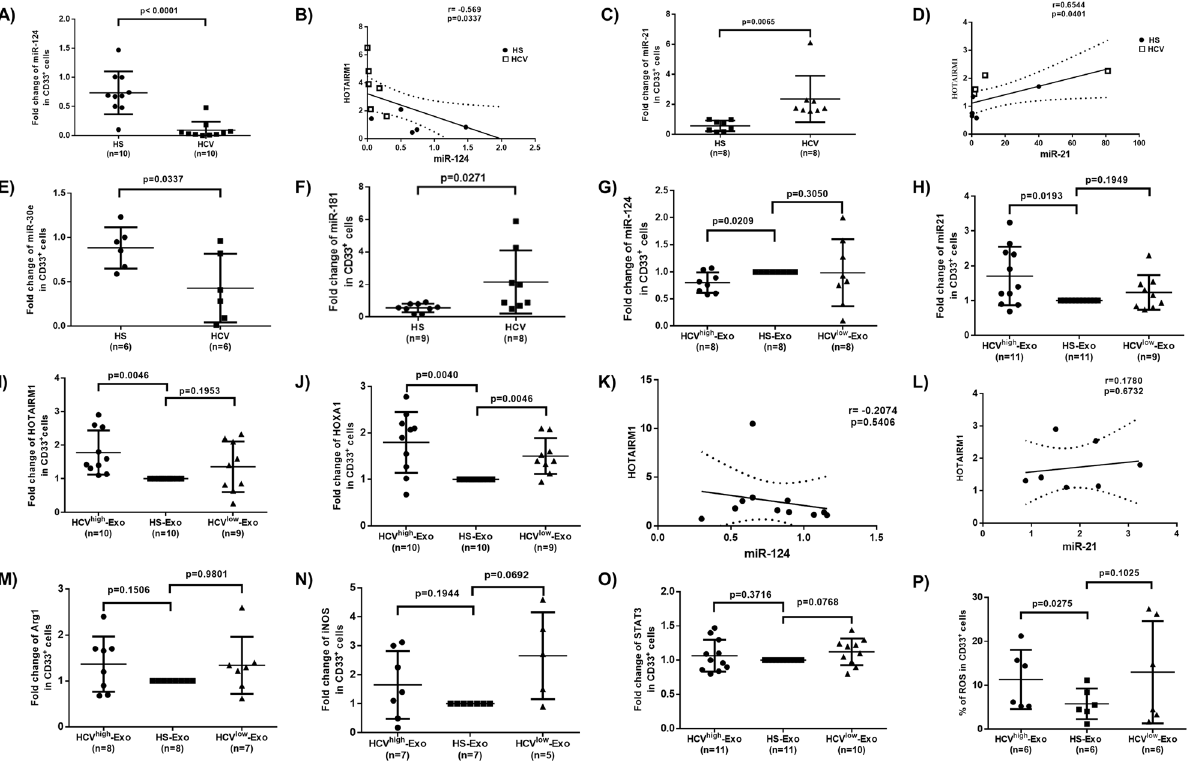
Figure 3. Analysis of miRNA, lncRNA, and mRNA expression levels in MDSCs during HCV infection in vivo and by HCV-Exo treatment in vitro. ( A–F ) Expression levels of miR124, miR21, miR30, miR181 and their correlation with HOTAIRM1 level in CD33 + cells isolated from HCV-infected individuals versus HS. ( G–L ) Expression levels of miR124, miR21, HOTAIRM1, HOXA1 and their correlations in CD33 + cells treated with exosomes isolated from plasma of HCV-infected individuals (HCV high -Exo or HCV low -Exo) and HS (HS-Exo). ( M–P ) Expression levels of Arg1, iNOS, STAT3, and ROS levels in CD33 + cells cultured with exosomes that were purified from plasma of HCV-infected individuals (HCV high -Exo or HCV low -Exo) versus HS